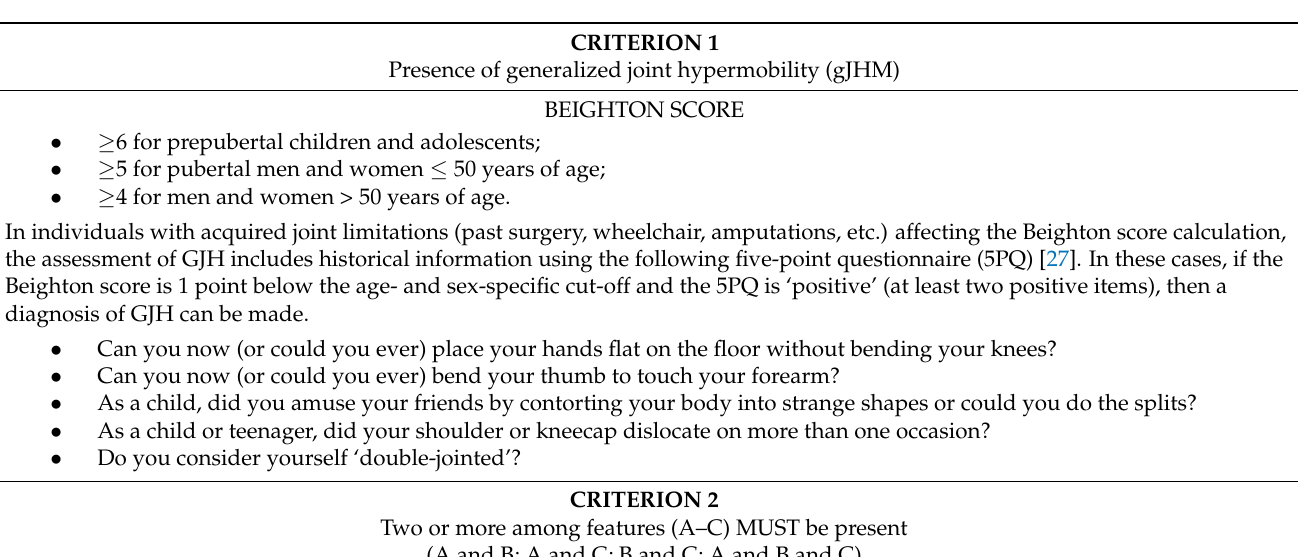
Table 1. hEDS diagnostic checklist listing the three mandatory criteria according to the 2017 nosology